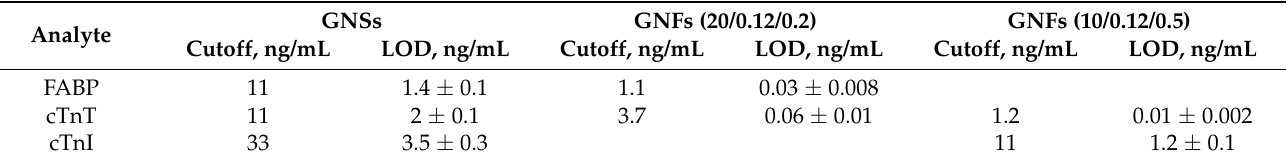
Figure 12. Detection of cTnI in buffer by LFIA using the conjugate GNFs (10/0.12/0.5)–Ab2/cTnI. ( A ) Appearance of test strips after analysis of samples containing 0 (1), 0.4 (2), 1.2 (3), 3.7 (4), 11.1 (5), 33.3 (6), 100 (7), and 1000 (8) ng/mL of cTnI. ( B ) Dependence of the coloration intensity of the TZs on the concentration of cTnI. Table 4. Analytical characteristics of test systems based on GNSs and GNFs.